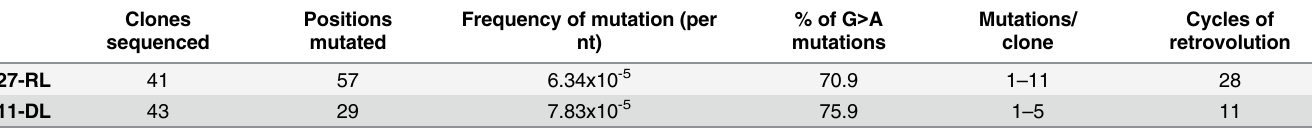
Frequencies of mutation are calculated as described in Materials and Methods; %G > A mutations: % of transitions from G to A among the number of mutated positions found; mutations/clone: range of mutations found in single clones (for the F10-DL library the three mutations present in G12 are not